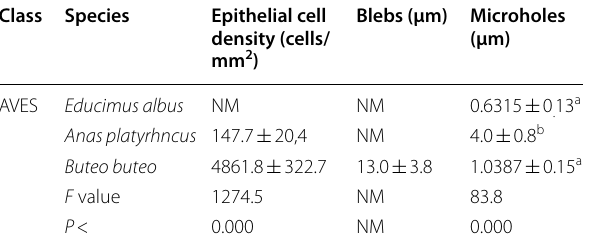
Table 4 Measurements of cell density and the diameter of various types of blebs and microholes for avian studied species: NM: not measured